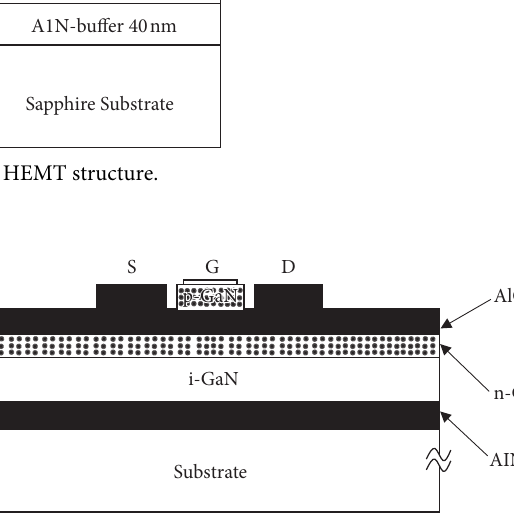
Figure 8: Schematic cross section of a p-n gate Ga-N HEMT [57].